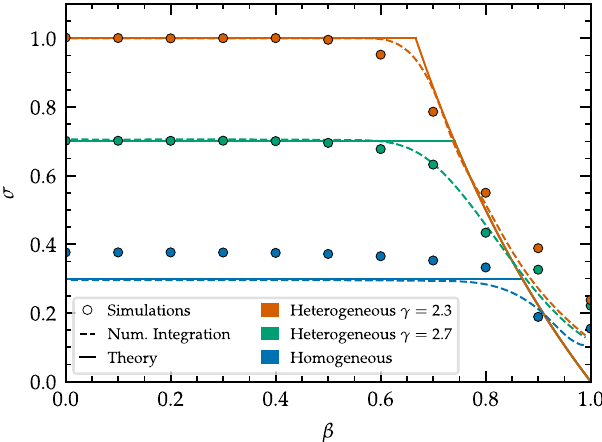
Fig. 4 Exponent of the average local clustering coef fi cient as a function of the inverse temperature. The exponent σ ( β ), de fi ned by c ð N ; β Þ (cid:3) N (cid:2) σ ð β Þ h ð N ; β Þ , with h ( N , β ) a non-power law function of N , evaluated from numerical simulations (colored circles), numerical integration of Eq. (8) (dashed lines), and theoretical approach Eqs. (11) and (12)) (solid lines). Networks are generated with a homogeneous distribution of hidden degrees (red lines and circles) and a power law distribution with exponents γ = 2.3 and γ = 2.7, blue and green lines and circles, respectively. Errorbars representing the standard error are smaller than the data points and therefore not